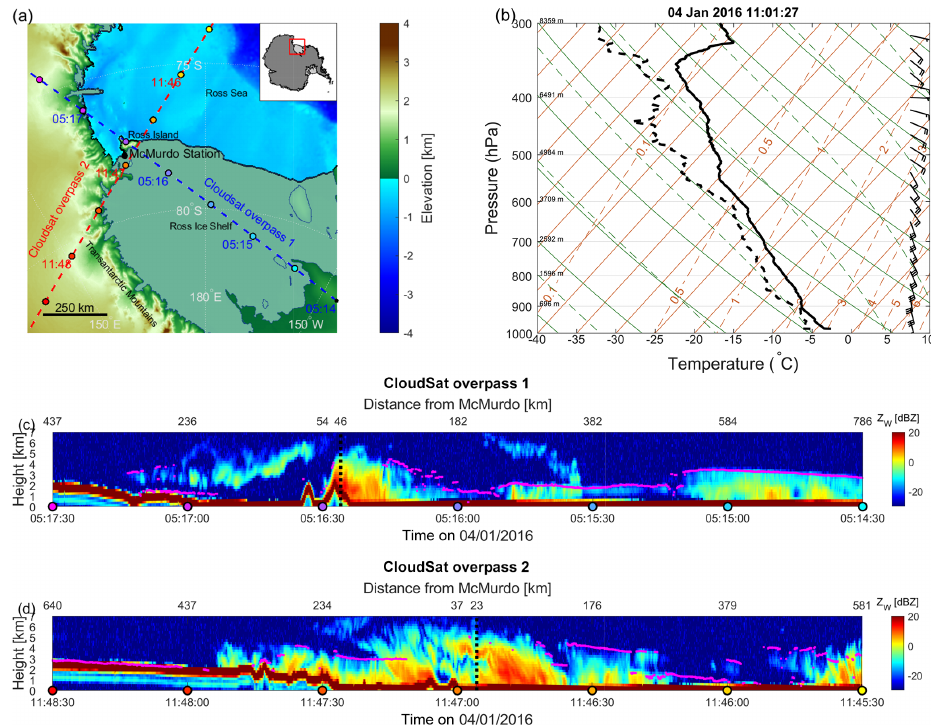
Figure 2. (a) Overview of the geographical features around McMurdo created with the Antarctic Mapping Tools for MATLAB (Greene et al., 2017). (b) Profiles of atmospheric temperature (continuous line) and dew point temperature (dashed line) measured by the 10:24UTC sounding from the AMF2 on 4 January. Time–height cross sections of the reflectivity measured during the ascending (c) and descending (d) CloudSat overpasses closest to McMurdo for the same day, indicated by the dashed blue and red lines in (a) (the colored circles in a and along the x axis of c , d are spaced by 30s timesteps along the satellite path (equivalent to 228km) and allow us to visualize the position of the cloud system better). The vertical dotted black lines in (c) and (d) show the time of the closest approach for each overpass, and magenta lines indicate supercooled liquid water clouds as detected by